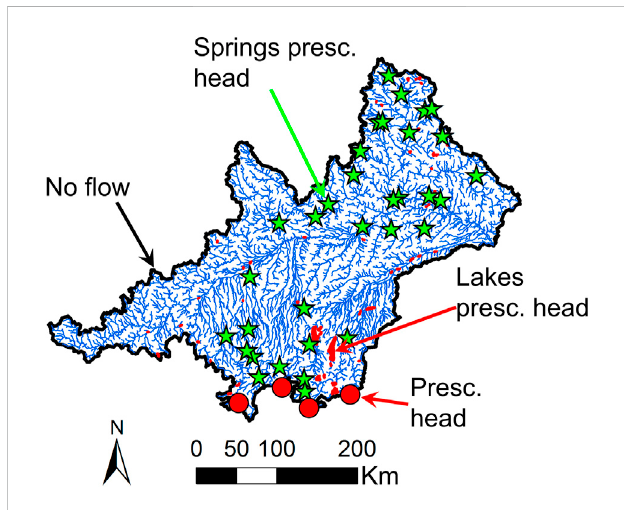
FIGURE 5 Boundary conditions of the groundwater numerical